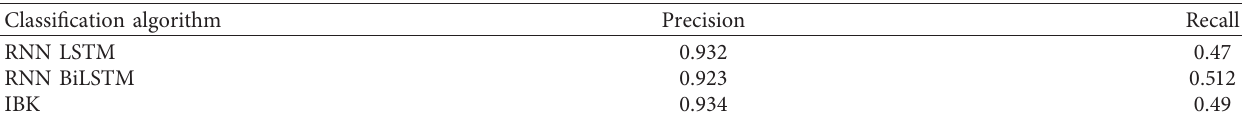
Table 6: Performance comparison of RNN and IBK algorithms based NN-QuPiD Attack with query string feature vector.